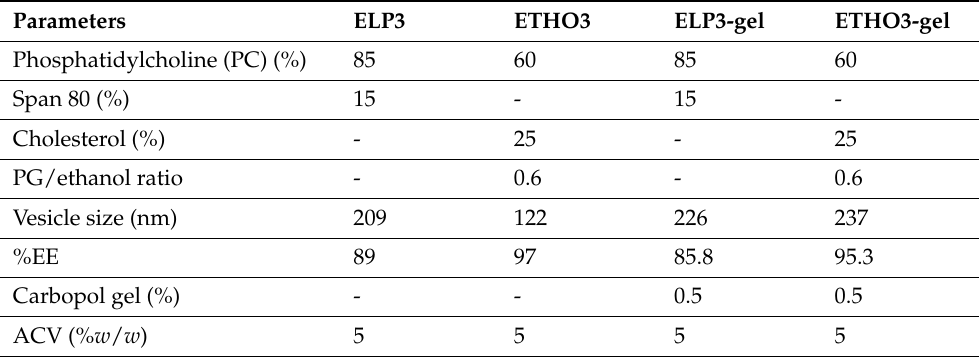
Table 3. Composition and prime characteristic parameters of ethosome and elastic liposome formula- tions (including respective gels) containing a constant amount of